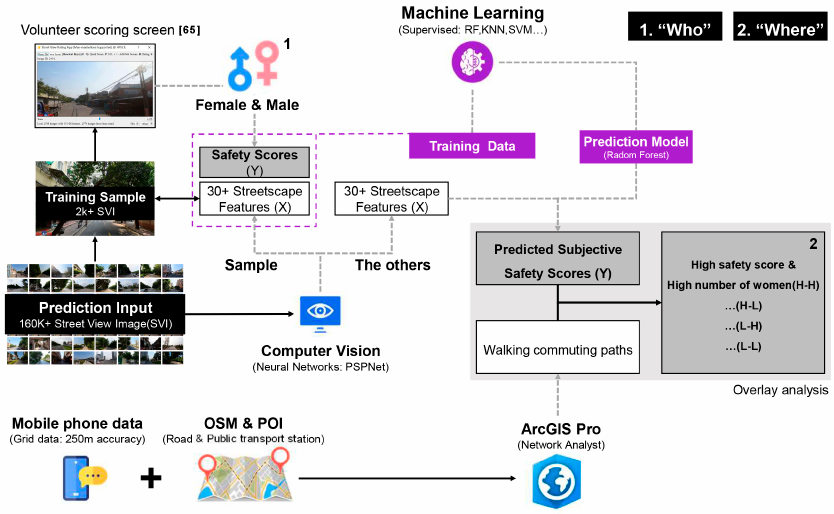
Figure 2. Analytical framework. Inspired by Xu et al. [66].